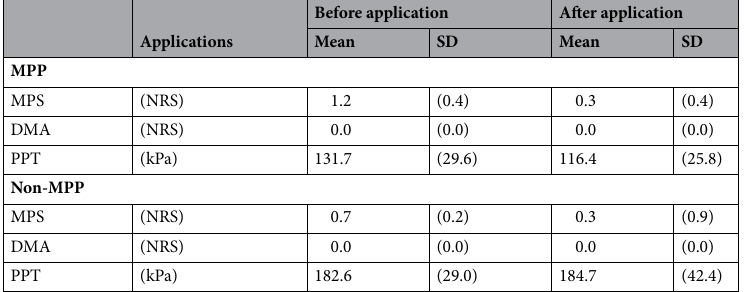
Table 3. Comparison of mechanical pain sensitivity (MPS), dynamic mechanical allodynia (DMA), and pressure pain threshold (PPT) on masseter muscle between before and after lidocaine application in the masseter muscle pain prone (MPP) and non-masseter muscle pain prone (non-MPP) groups. All data are presented as mean and standard deviations of the mean. MPS = mechanical pain sensitivity (mean pain